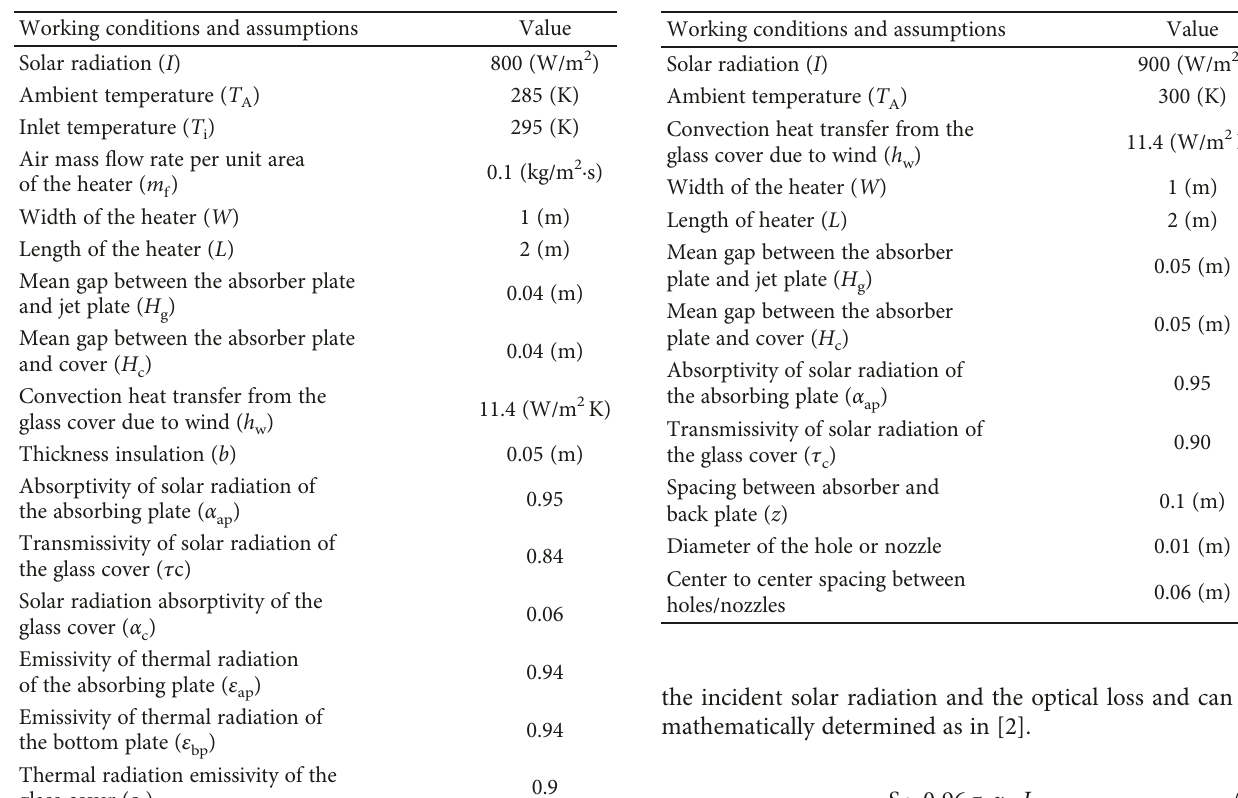
Figure 12: Block diagram of the calculation steps. Table 1: The assumptions and working conditions of the SAH with Table 2: The assumptions and working conditions of jet a cross-corrugated absorber plate in [36]. impingement on a fl at absorber plate in